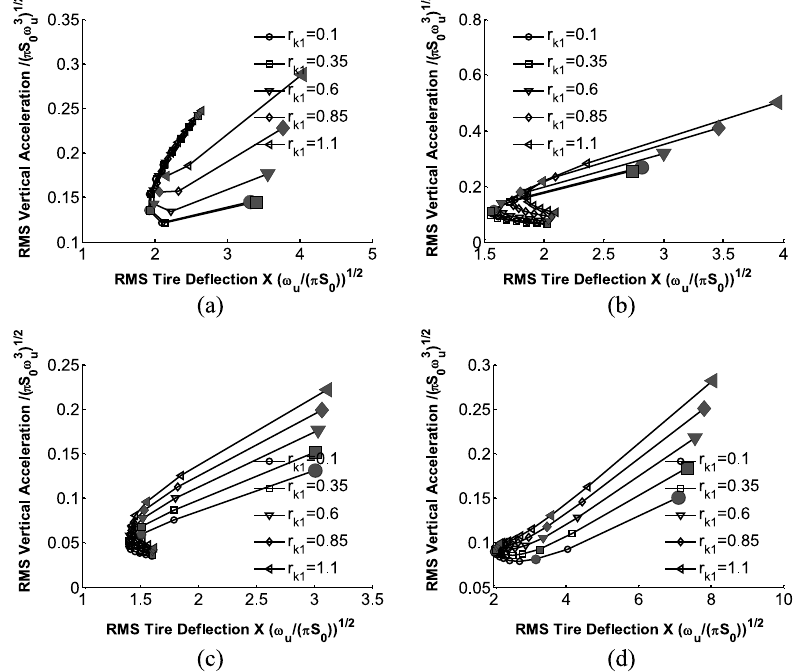
Fig. 9. Relationship between RMS acceleration and RMS tire de fl ection with layout s8 (effect of centering spring k 1 and damping): (a) Passive; (b) Groundhook; (c) Hybrid; (d)